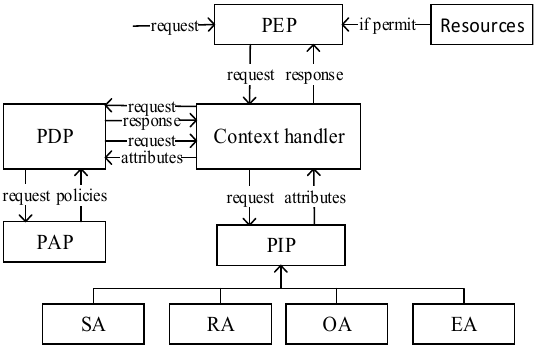
Figure 1. The data flow model of the XACML framework.